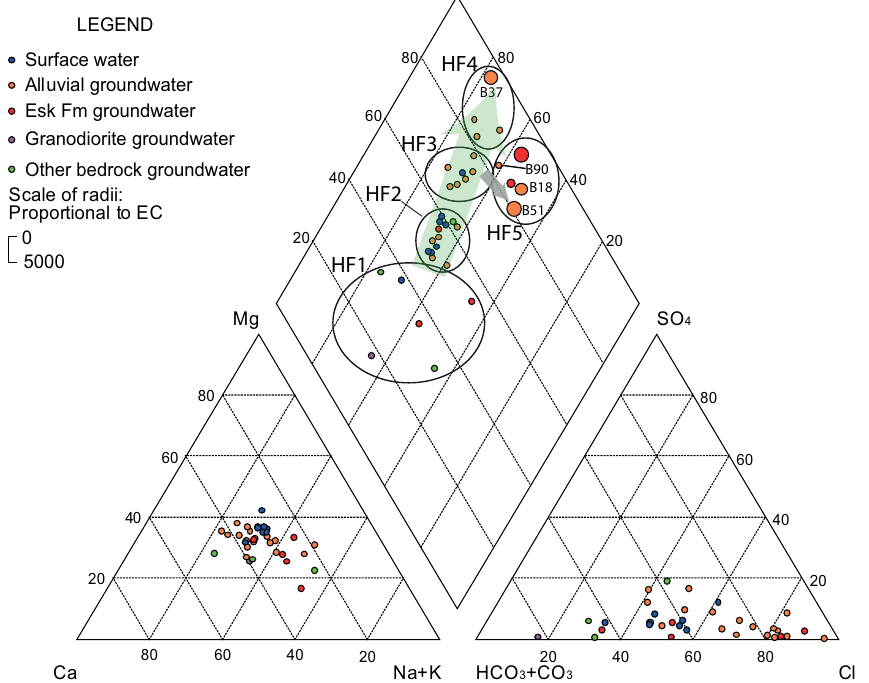
Figure 5. Piper diagram showing hydrochemical facies (HF) for surface and groundwater samples collected in the Cressbrook Creek catch- ment. The green and grey arrows show divergent evolutionary pathways.